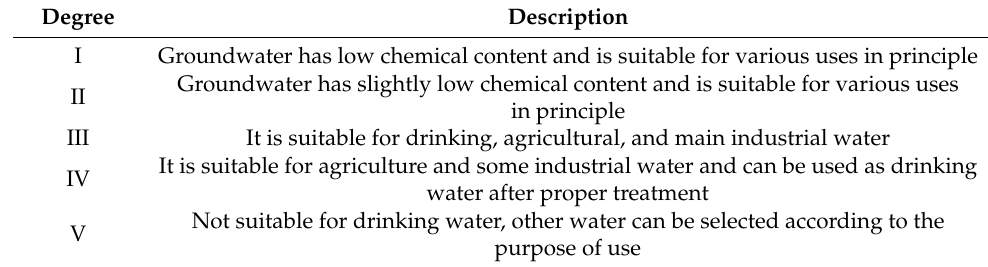
Table 1. Groundwater quality